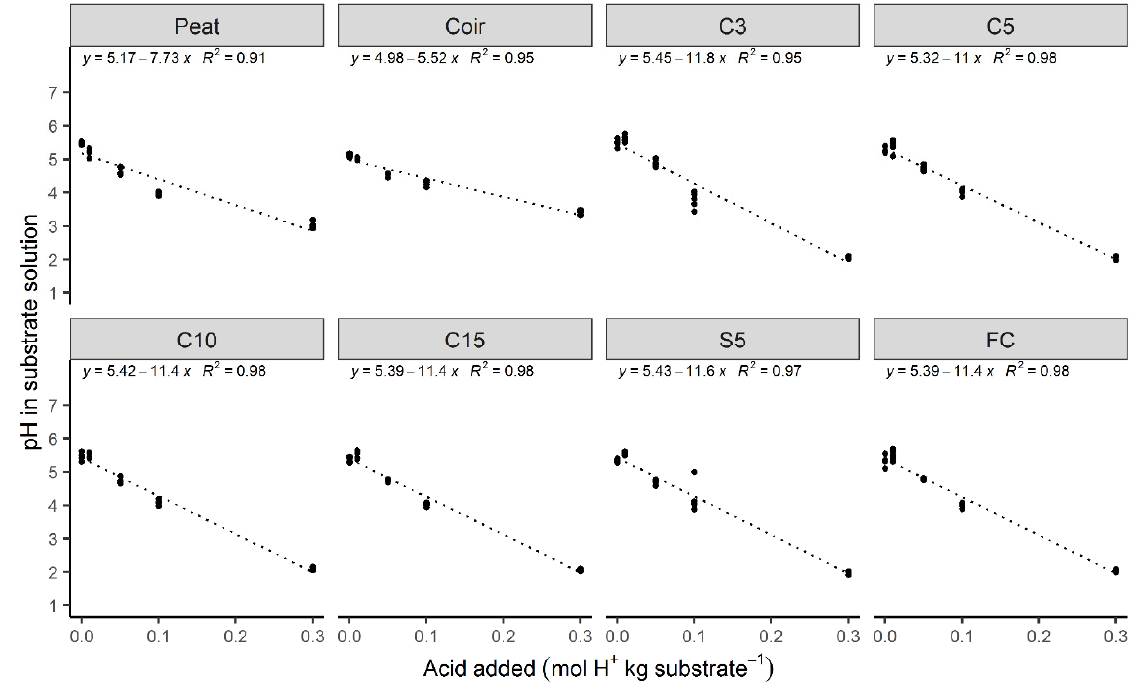
Figure 7. Linear regression for the determination of pH buffering capacity of peat, coir, and six processed miscanthus substrates. Each point represents for one sample. For each substrate at each proton concentration, there are 5 replicates. Miscanthus × giganteus was harvested with a forage harvester (FC, field-chips), then processed with a mechanical fraying facility through a 5-mm screen (S5, shreds) or a hammermill with screen sizes of 15, 10, 5, and 3 mm (C15, C10, C5, and C3, chips). Table 7. Initial pH and pH buffering capacity of peat, coir, and six processed miscanthus substrates.